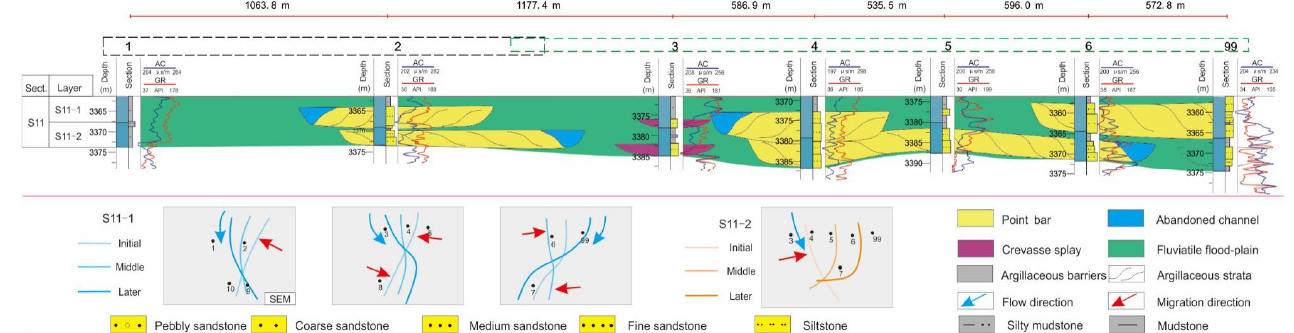
Figure 14. Profile L5 of comprehensive analysis including evolution model of meander bend-based multiple connected core wells which are collected from database in S 11 sublayer of Su-X block, Sulige gas field, Ordos Basin, China: migration areas Z1 (green frame), Z4 (gray frame), Z6 (orange frame).